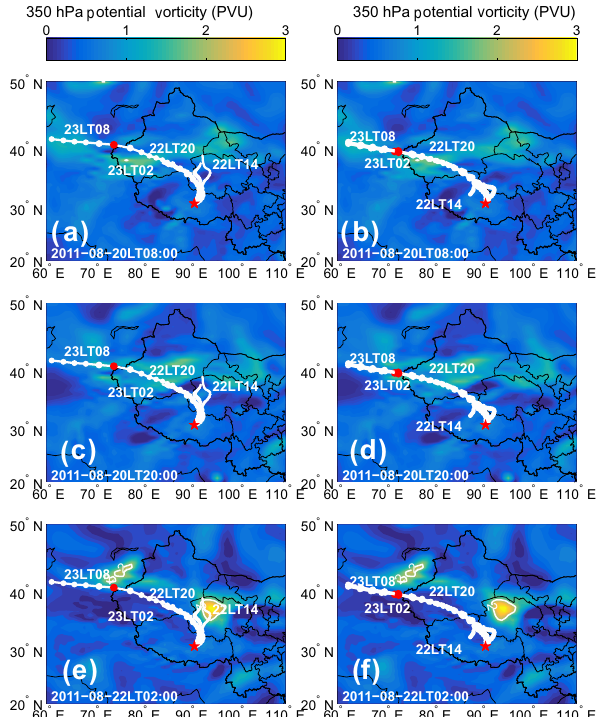
Figure 10. Same as Fig. 9, but for 22–23 August 2011. Data in Fig. 5 indicate that the monsoon flow prevailed persistently after the middle of June 2012, and there were when the PAN level was increased to near 1 ppb. After this abrupt rising, PAN dropped down to a much lower level,